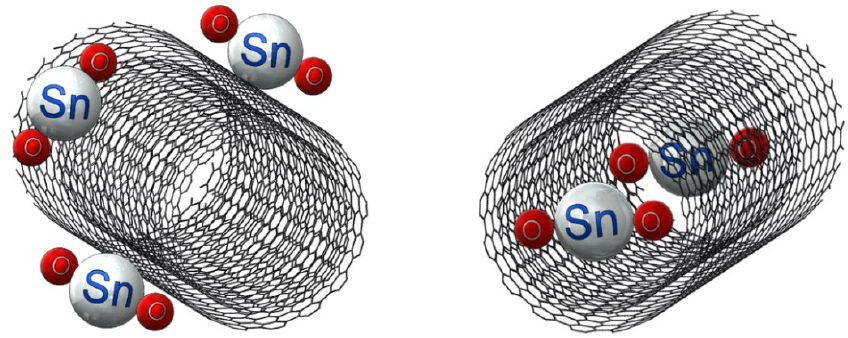
Figure 1. Schematic of unconfined SnO 2 on a CNT and confined SnO 2 in a CNT.